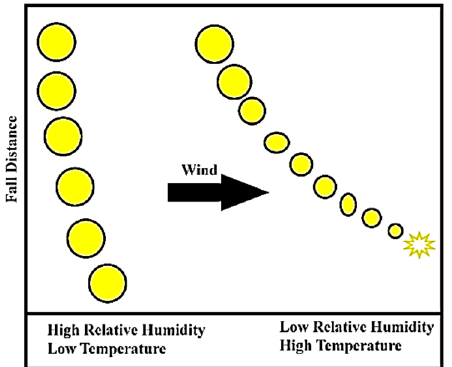
Figure 6. Effect of humidity and temperature on spray droplet size and movement.